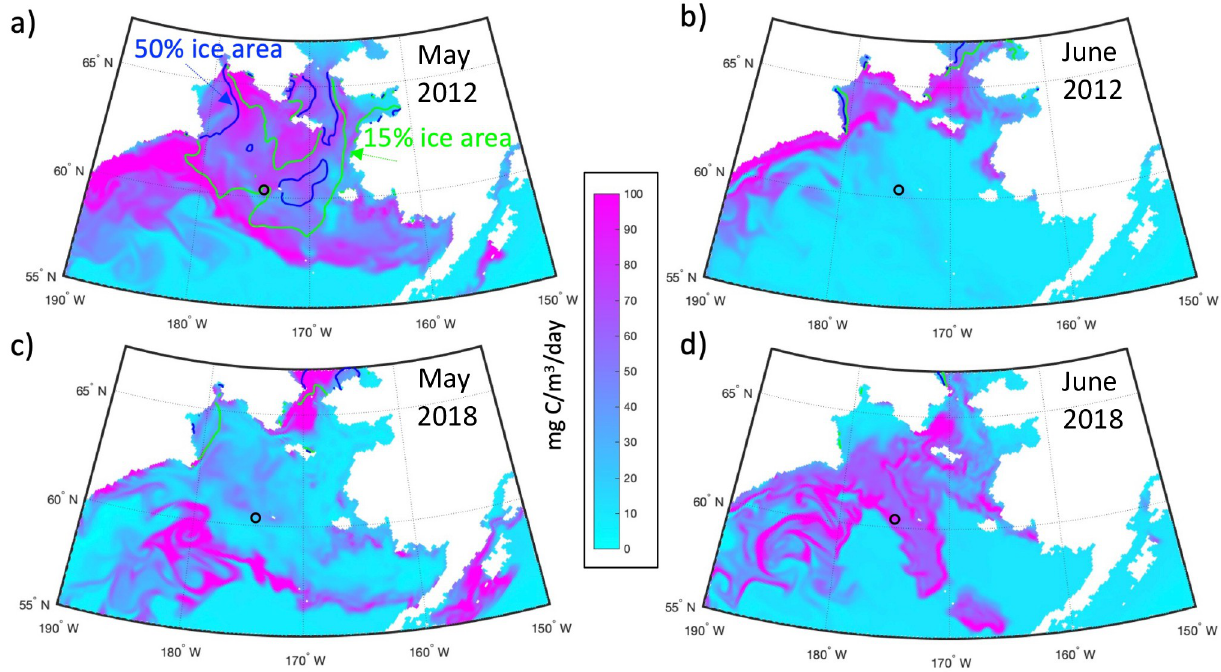
Fig 10. Surface primary production. Surface primary production (mg C / m 3 / day) during May (a, b) and June (c, d) for years 2012 (a, c) and 2018 (b, d) from RASM. The blue line indicates the 50% ice area contour and the green line indicates the 15% ice area contour. Small black circles at 60.5˚N, 175˚W denote the location of vertical profiles shown in Fig 11. Figure created using Matlab (v. 2018a) from the authors’ data.